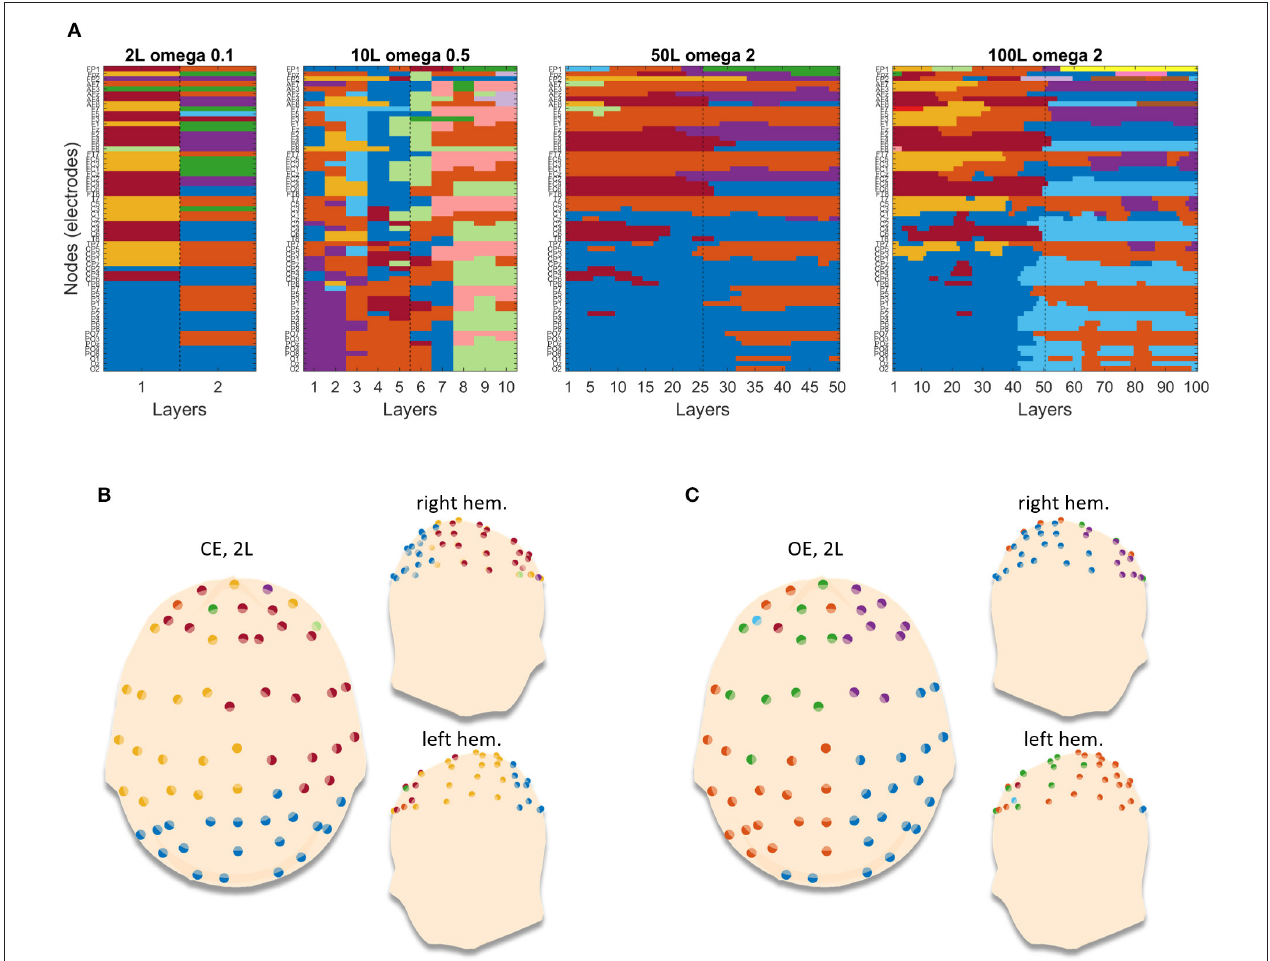
FIGURE 6 | Example of partitions obtained by running genLouvain on the EEG brain networks. (A) The four images stand for the four networks with different numbers of layers. Each image has on the y-axis the nodes (channels) and on the x-axis the layers, and the cluster’s membership is represented through colors. (B,C) Reported projections of the detected communities on a 3D model of scalp for the two conditions, closed eyes and open eyes, respectively. In each panel, the 3D model is seen from above, with the nose pointing to the upper side of the page, and laterally. The dots are the 61 electrodes grouped into clusters and displayed with different